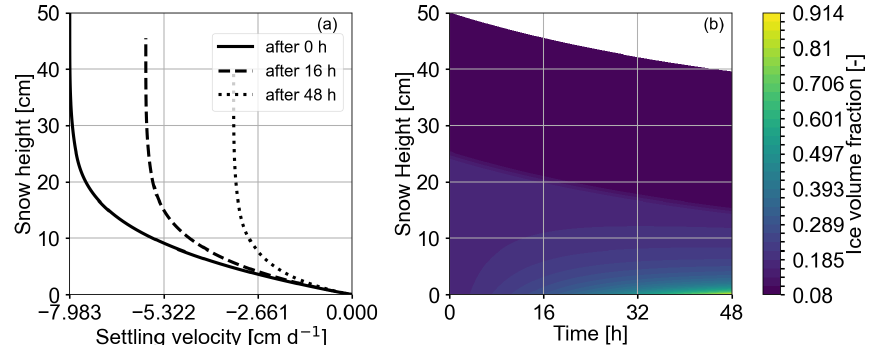
Figure 11. The plots show vertical velocity profiles over snow height (a) and the evolution of the ice volume fraction (b) for Case 8 of Table 2, which refers to the fully coupled processes combined with a non-linear Glen’s law. Velocity (a) varies less compared with a linear version of Glen’s law, which yields a more uniform evolution of the snowpack’s ice volume fraction (b) . In (b) we interpret the locations of the upper layer as the darker area with an almost constant extent in the upper part and that of the lower layer as the slightly lighter area